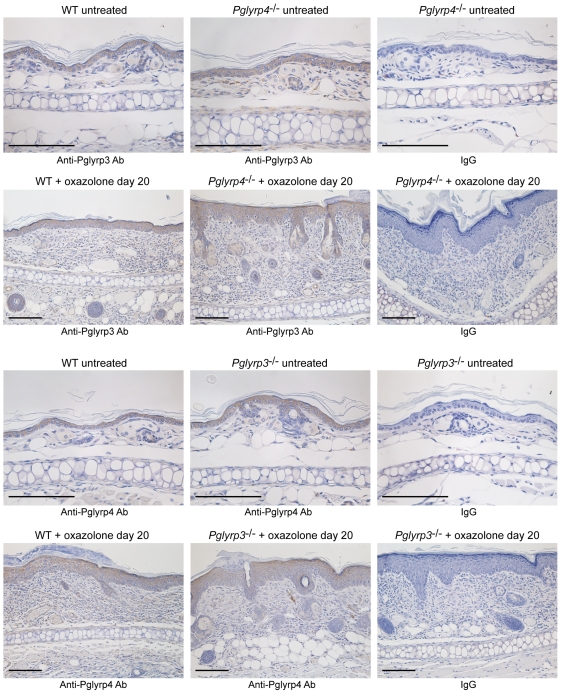
Pglyrp3 and Pglyrp4 are expressed primarily in the differentiated epidermal cells in both untreated and oxazolone-treated skin in the atopic dermatitis model.Transverse sections of the ears from either untreated or oxazolone-treated mice (sensitization followed by 10 applications of oxazolone to the ears every other day) were stained by an immunoperoxidase method with either anti-Pglyrp3 or anti-Pglyrp4 antibodies or IgG (negative control); bar = 50 µm.